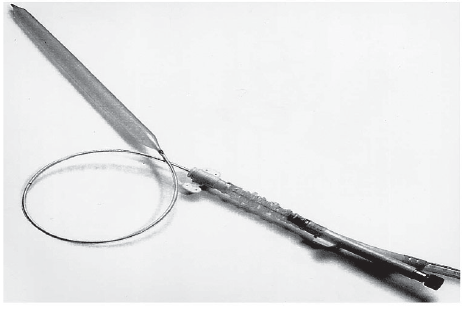
Figure 14. Laparoscopy tools. The actions of grippers, scissors, tongs and other mechanisms are performed by SMA. Taken from Ref. 16 with